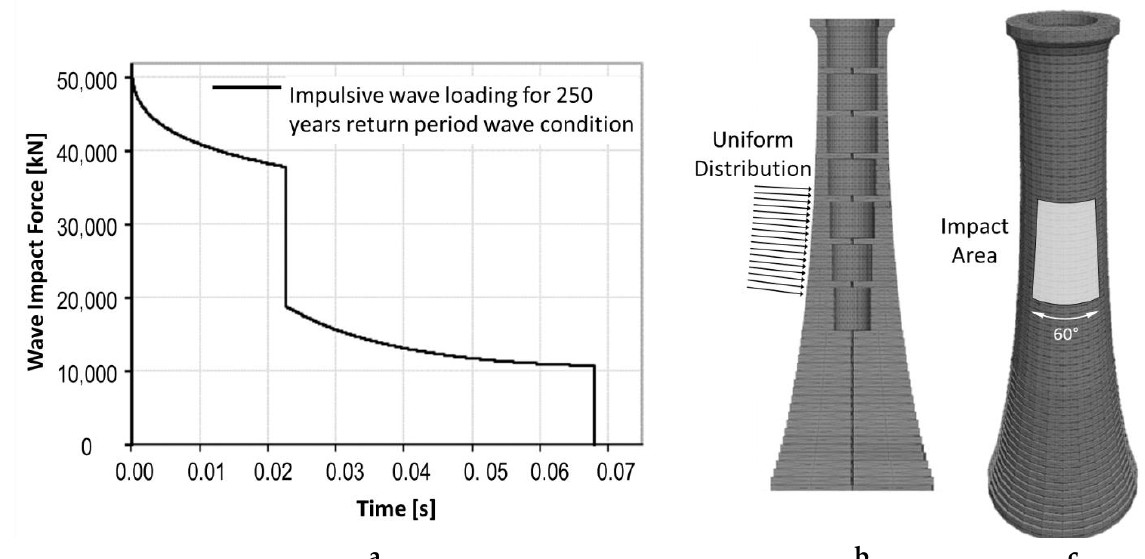
Figure 5. Wave impact force of H 0.1% derived from 250-year return period sea state for Wolf Rock lighthouse: ( a ) dynamic loading force – time-history; ( b ) uniform distribution of forces; ( c ) impact area.